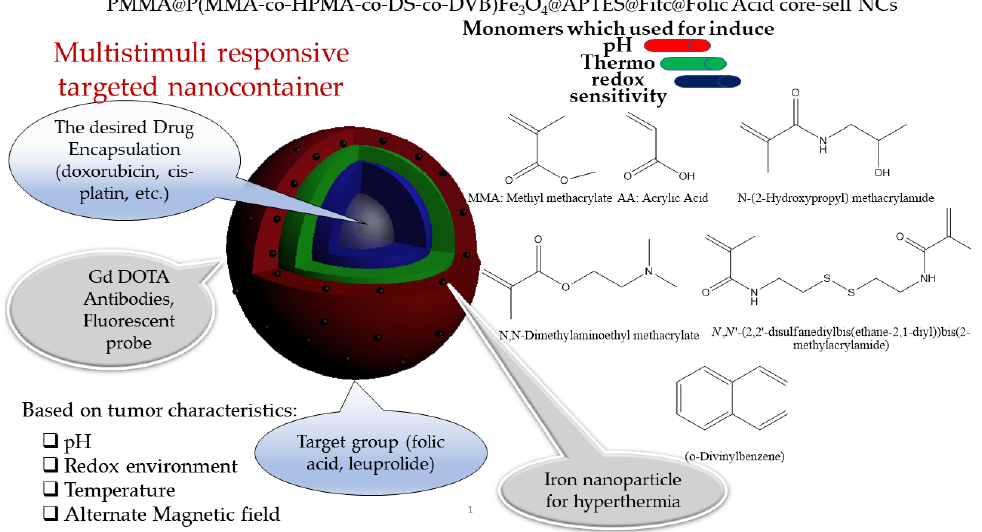
Figure 1. Quadrupole stimuli-responsive targeted nanocontainers loaded with cancer therapeutic drugs to treat cancer: the Nano4XX (Dox, Cis, etc.) platform.